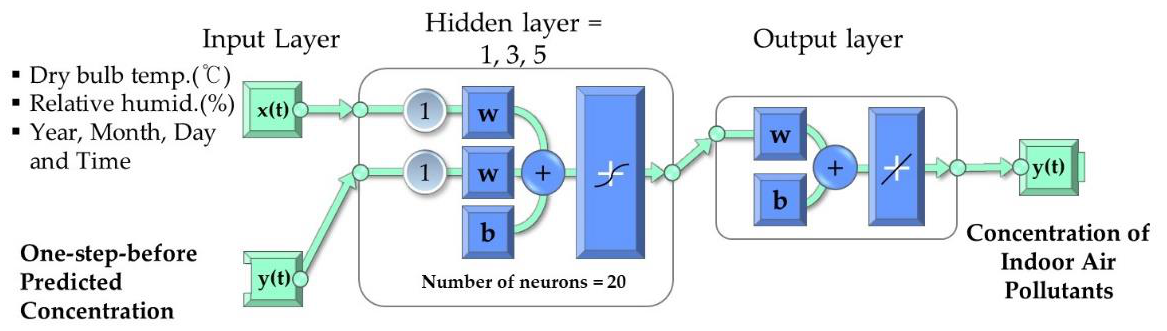
Figure 2. Schematic of the multilayer shallow neural network training algorithms for predicting indoor air pollution concentrations.